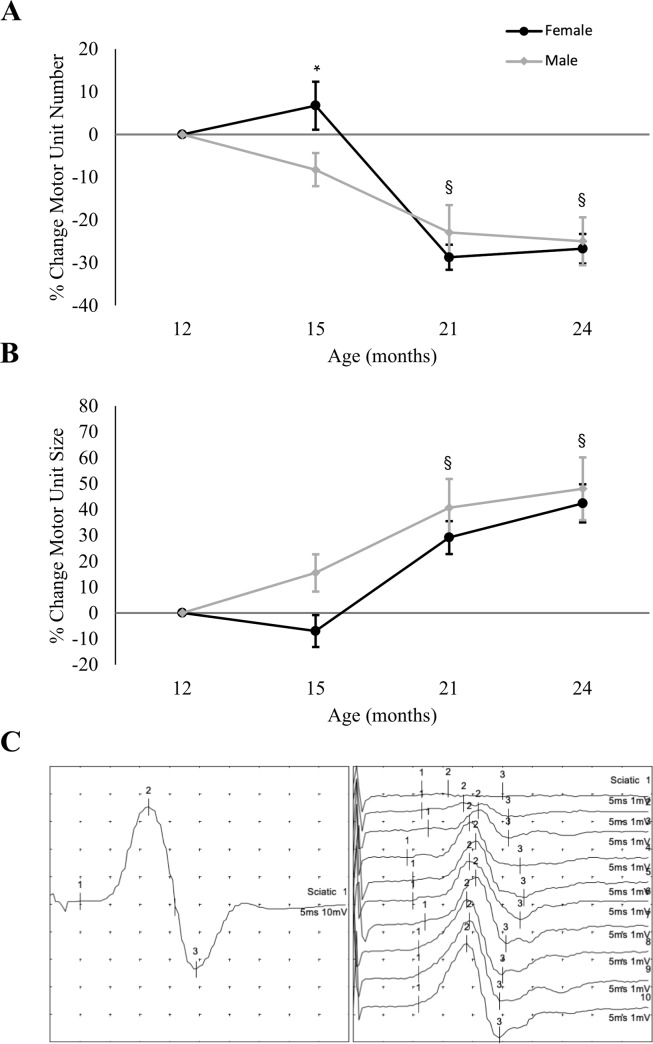
Longitudinal changes in electrophysiological motor unit characteristics of male and female mice following long term DOX treatment.DOX treatment had no significant effect on motor unit characteristics, and percent change in motor unit number (A) and size (B) from the 12-month baseline was the result of time. Treatment groups were collapsed to better show this age-related impairment. (A) In both male and female mice there was a reduction in motor unit numbers by 21 months of age. Interestingly, at age 15 months female mice maintained their numbers while male mice had already experienced a reduction that was significantly different from females. From that time point, measures in both groups were significantly reduced from baseline. (B) As anticipated, increases in average SMUP size paralleled the decline in MUNE shown in A. At age 21 and 24 months the increase in SMUP size was significantly different from the 12-month baseline. (C) Representative trace of the electromyographic recordings (methodological details given in the text). M, male; F, female. § indicates significant difference from baseline measurements (effect of time) (p <0.05); the asterisk (*) indicates significant difference between male and female mice at specified time point (p < 0.05). Values are mean ± SEM.